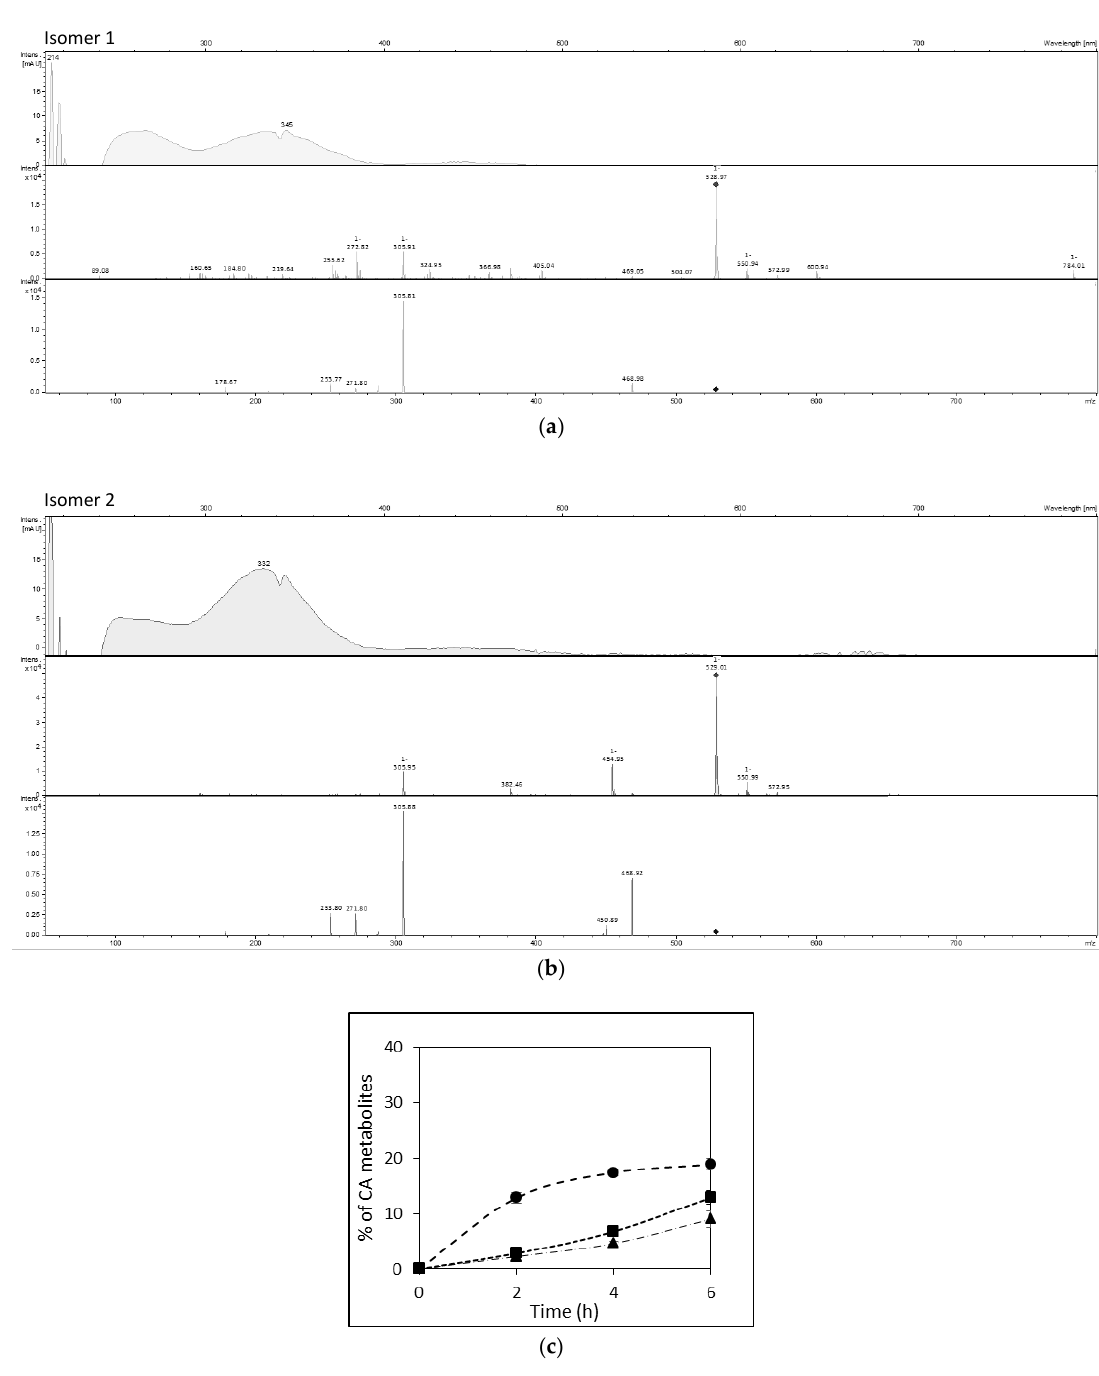
Figure 4. ( a ) and ( b ) UHPLC-DAD-MS analysis of caffeic acid metabolites. UV-visible, MS1 and MS2 data of two isomers tentatively identified as oxidized CA trimers (CA3: m / z = 3 × 180 − 4 − 1 = 535, oxidized CA3 (CA3-6H): m / z = 536 – 6 − 1 = 529). ( c ) Metabolites of CA from alperujo in culture media (B). Values are expressed in CA equivalent as mean ± SD ( n = 4). ●: FA in the basolateral side; ■ : isomer 1 of CA metabolite in cells; ▲ : isomer 2 of CA metabolite in cells.